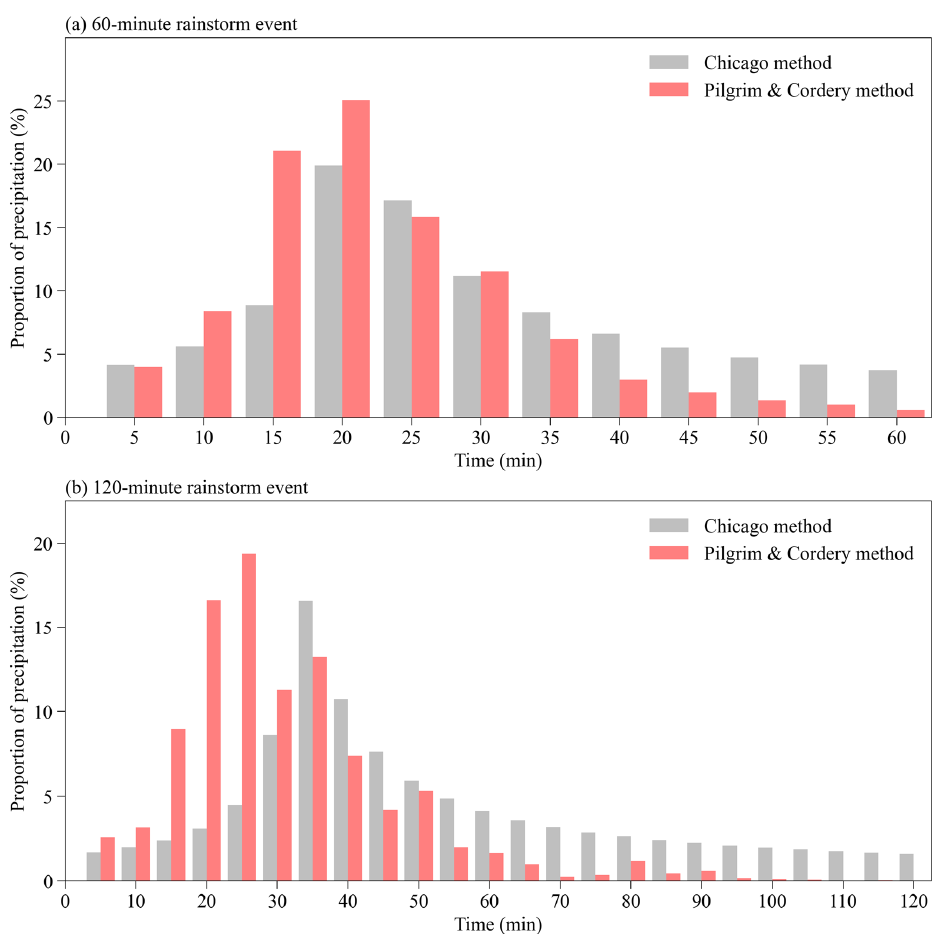
Figure 12. The storm patterns of rainstorms designed using PC method and Chicago method; ( a ) 60 min rainstorm and ( b ) 120 min rainstorm.